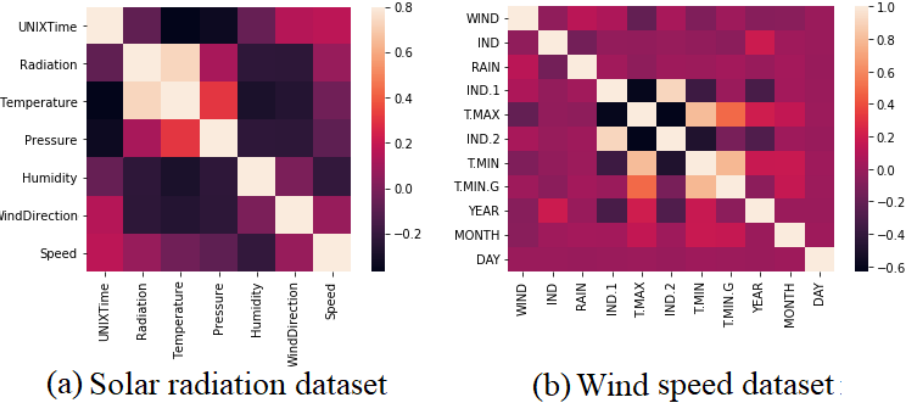
Figure 1. Heatmapof the correlation between the features of ( a ) solar radiation dataset and ( b ) wind speed